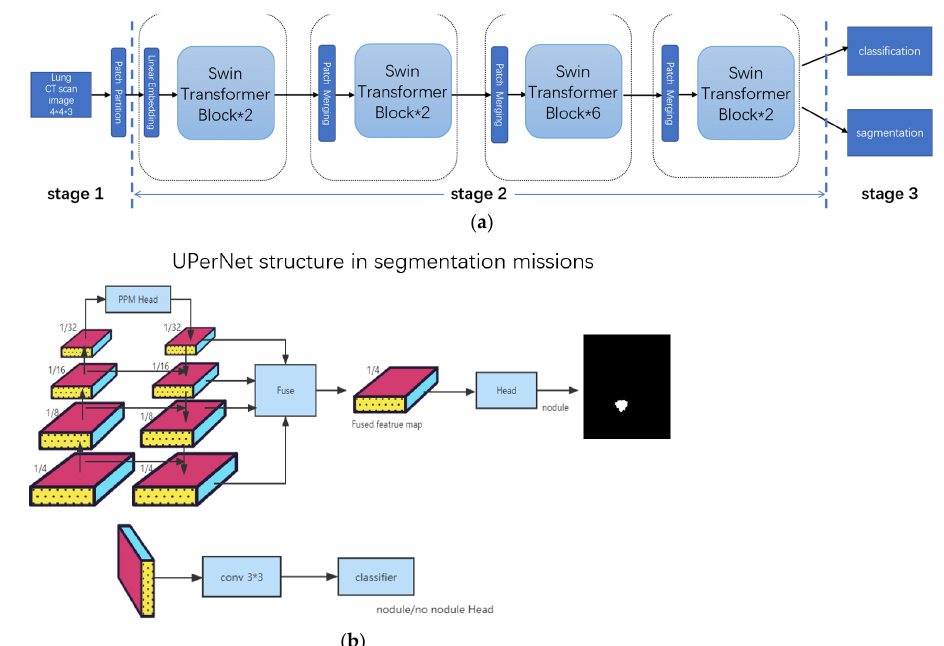
Figure 2. ( a ) Lung cancer detection process (Swin-T); ( b ) UPerNet structure in segmentation mis- sions.